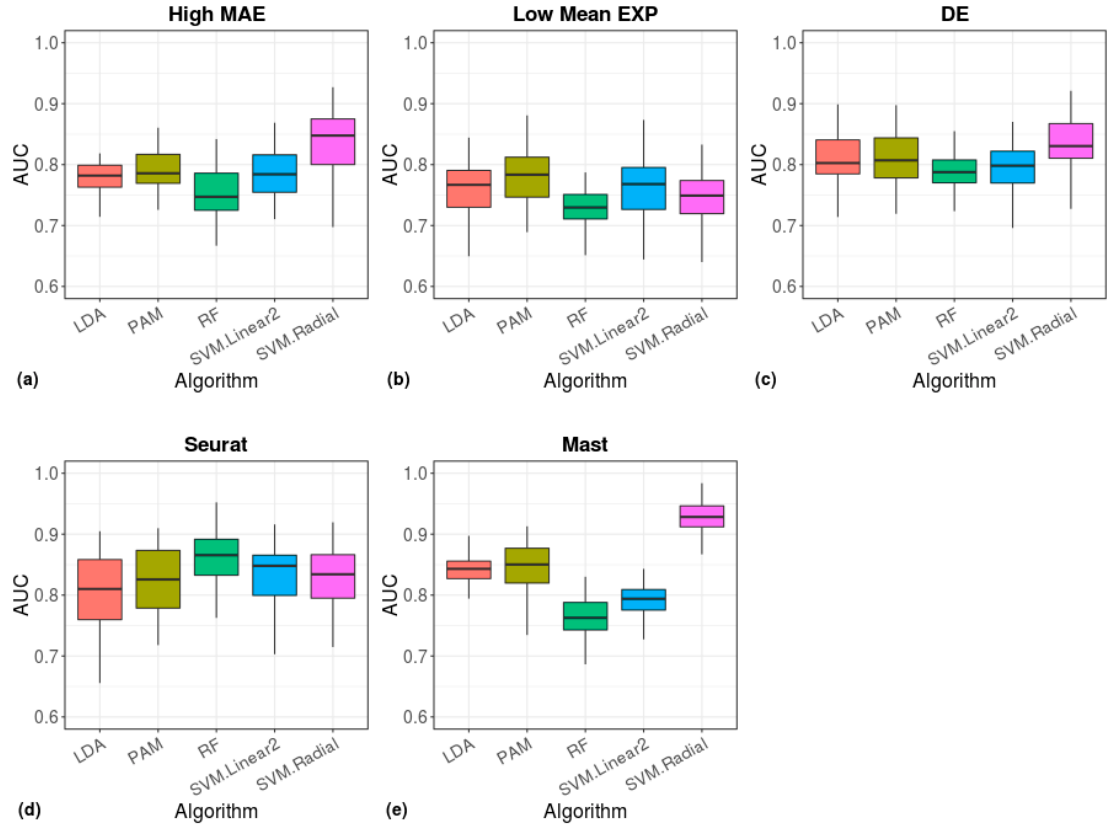
Figure 9. Cell type prediction accuracy of machine-learning algorithms. The area under the ROC curve (AUC), showing the performance of the indicated models in classification of cell types. The models were based on cell scores calculated from the 200 high-MAE ( a ), low mean-EXP ( b ), DE ( c ), Seurat ( d ), or MAST ( e ) gene sets.